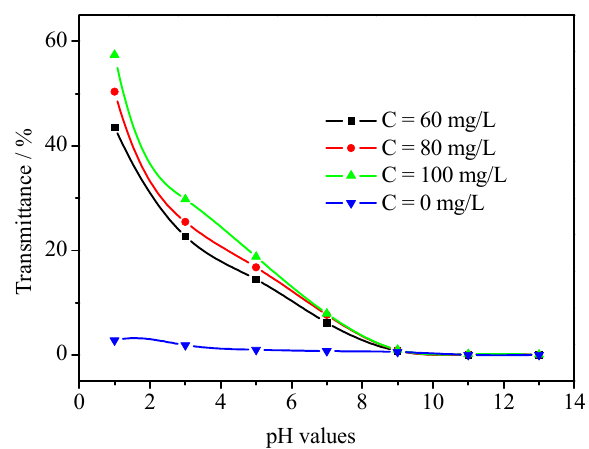
Figure 8. The utilization of H-PAMAM-ETA at different pH values and dosages for demulsification of the microemulsion.